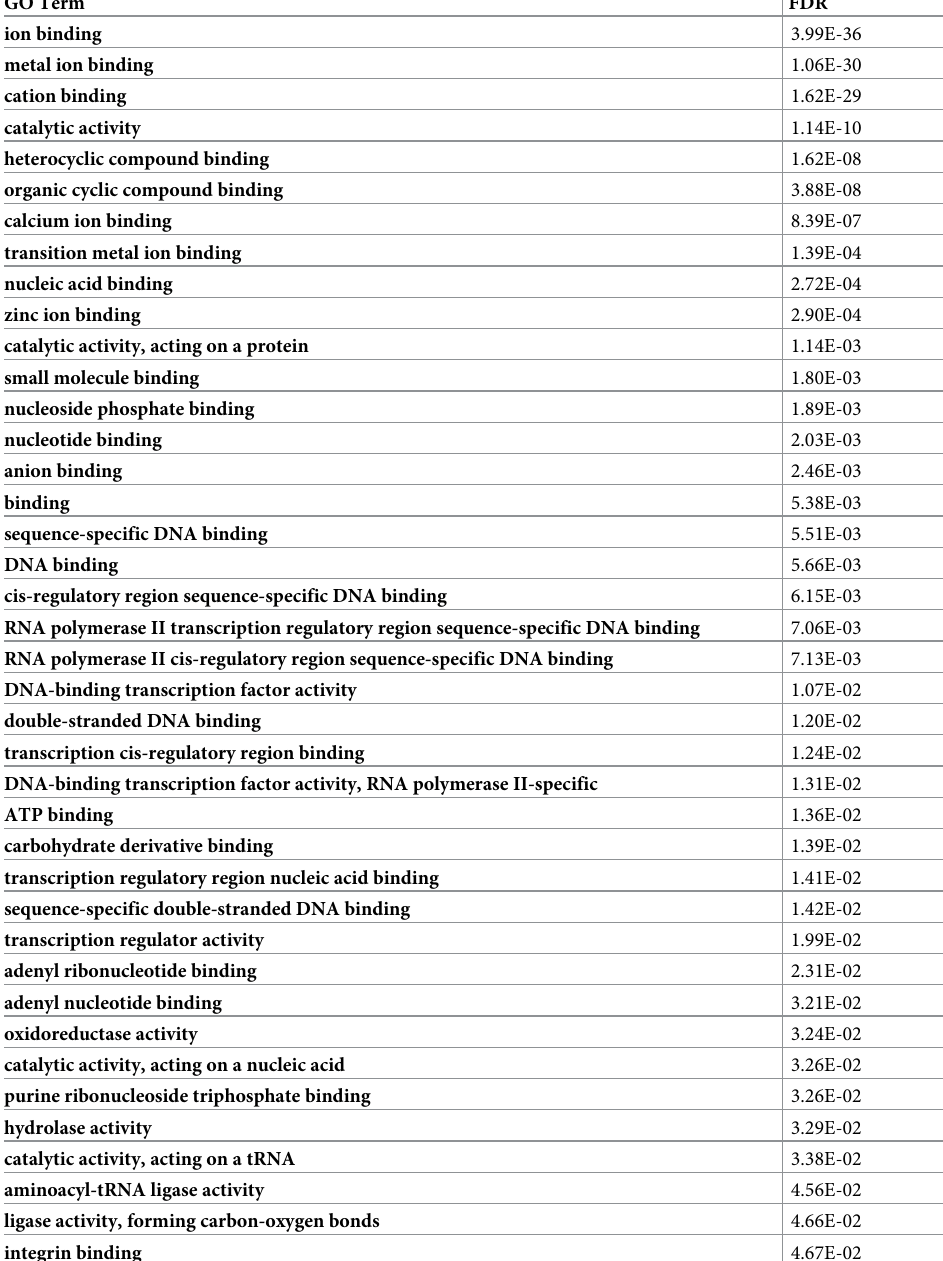
Table 2. GO terms for 1160 orthogroups with variable ligand interfaces. Significant GO terms (FDR < 0.05) are listed for proteins that contain at least one variable ligand contacting